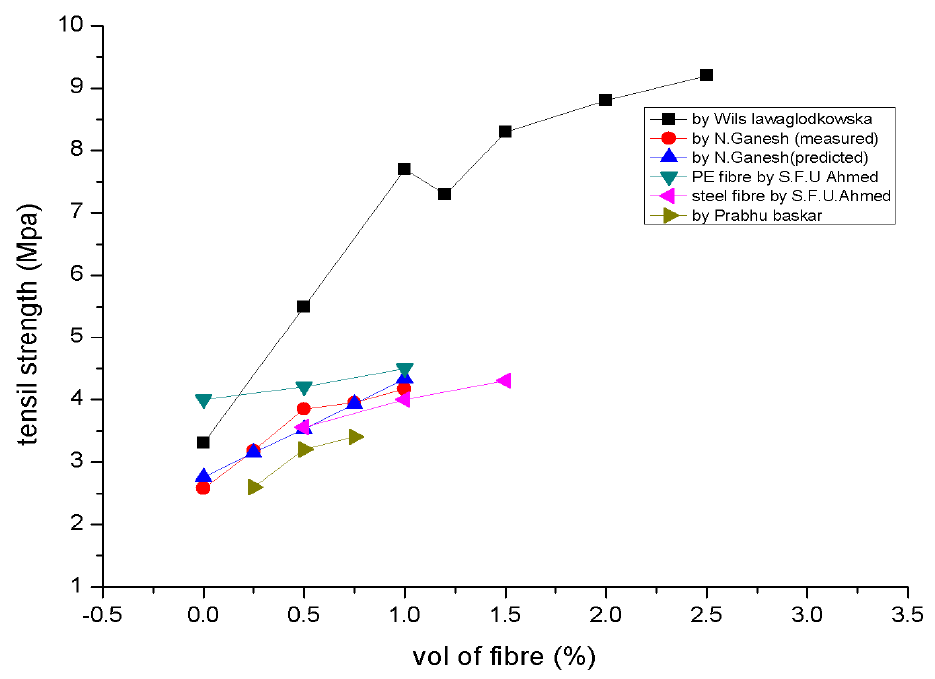
Figure 6. Splitting Tensile Strengths [89,92,105]. Comparing ultra-high-performance fibre-reinforced concrete (UHPFRC) to UHPC, steel fibre content significantly improved tensile strength. It can be demonstrated that when compressive strength rises, splitting tensile strength climbs [116]. The A1 mixture, A3 mixture, and A5 mixture all had split tensile strengths of 2.28, 2.07, and 1.64 MPa, respectively, after 28 days. Regarding completely substituted cement with GGBFS, as well as added steel and glass fibres, these hybrid fibres exhibit an enhanced split tensile test. The findings imply that the inclusion of polypropylene (PP) fibres have an impact on fly ash concrete’s splitting tensile strength. At 28 days, concrete containing 60 and 120 kg/m 3 fly ash had splitting tensile strengths similar to that of PC concrete. The optimal fibre content for all concrete is 0.45 kg/m 3 , according to the splitting tensile strengths of the concrete mixture. According to [117], strength ratings for engineered cementitious composite (ECC) without slag were much lower than those for slag tensile ECC (5.2 MPa) [118]. Hardened concrete properties are explained in Table 4 [16,44,56,95]. Figure 7 represents flexural strength